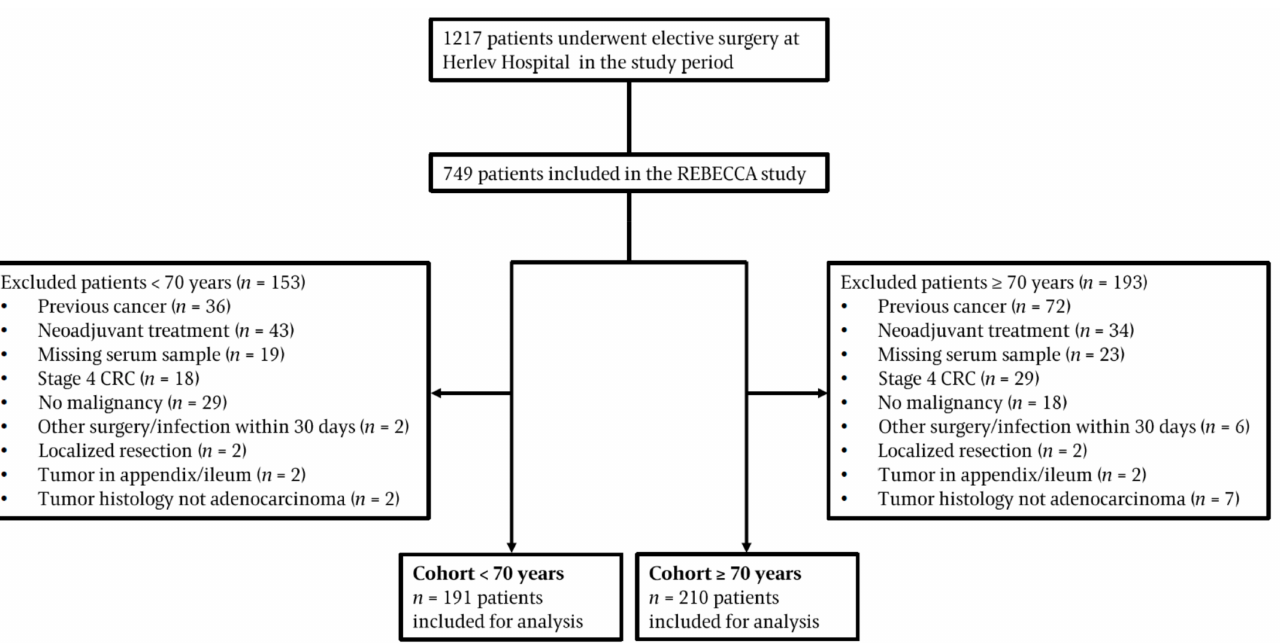
Figure 1. Patient flow. Abbreviations: CRC, colorectal cancer.